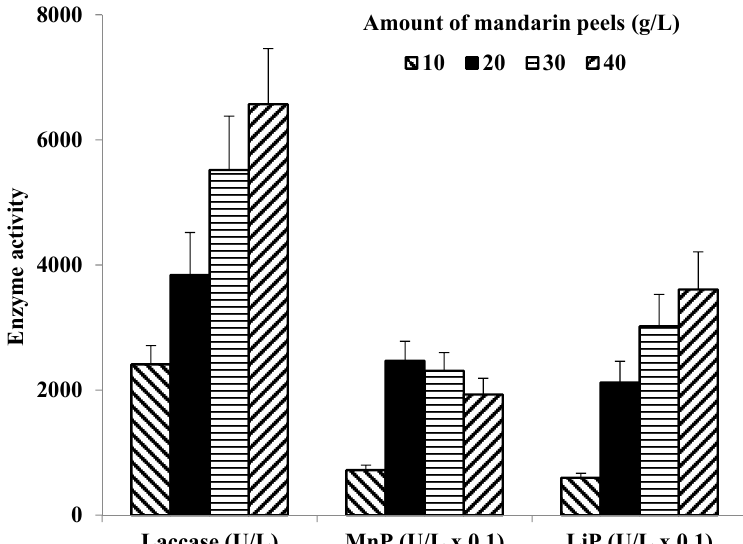
Figure 1. The effect of amount of mandarin peels in the cultivation medium on C. gallica 142 LME activities. The synthetic medium containing 10 g/L glycerol was supplemented with mandarin peels at various concentration.